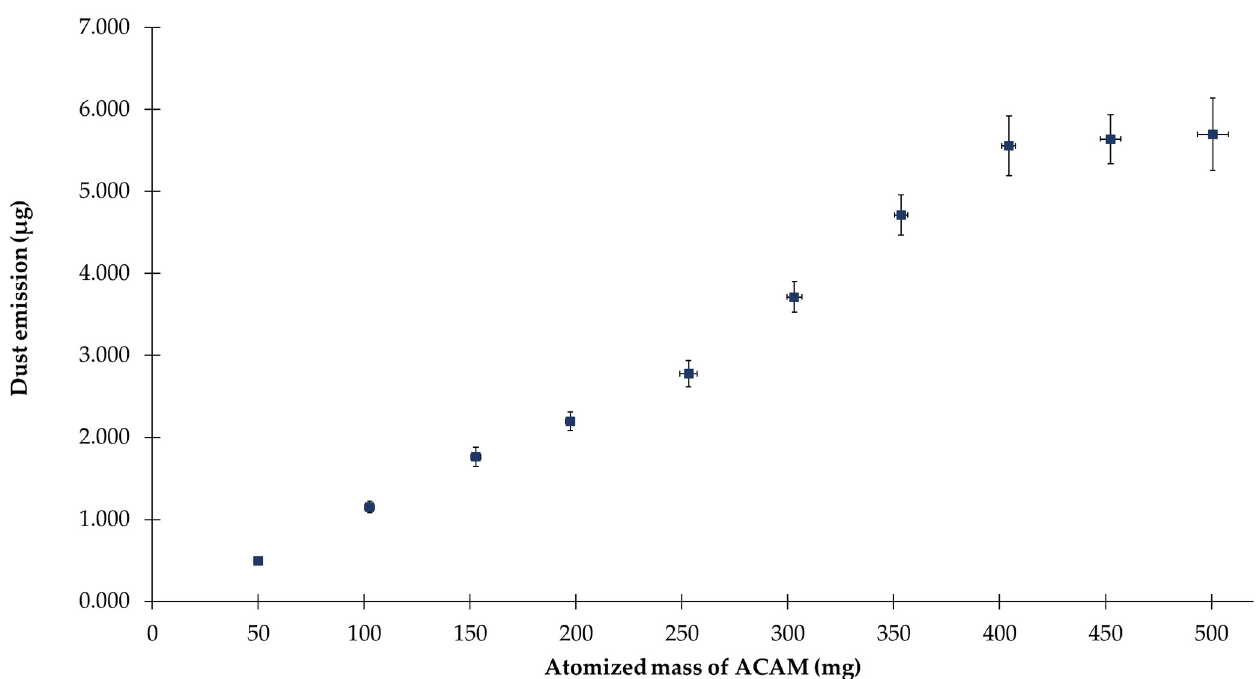
Figure 6. Dust emission versus the atomized mass of ACAM (means ± SD, n = 6).